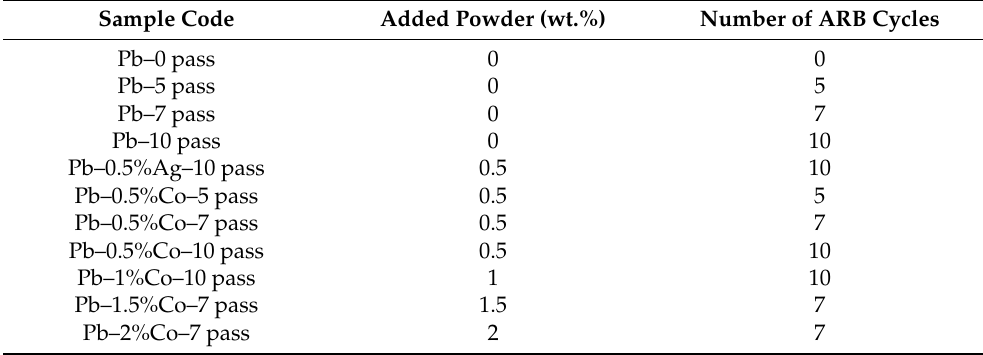
Table 2. Designation of different